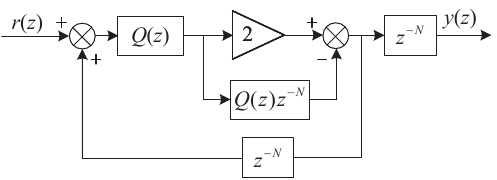
Figure 4. Block diagram of the proposed modified